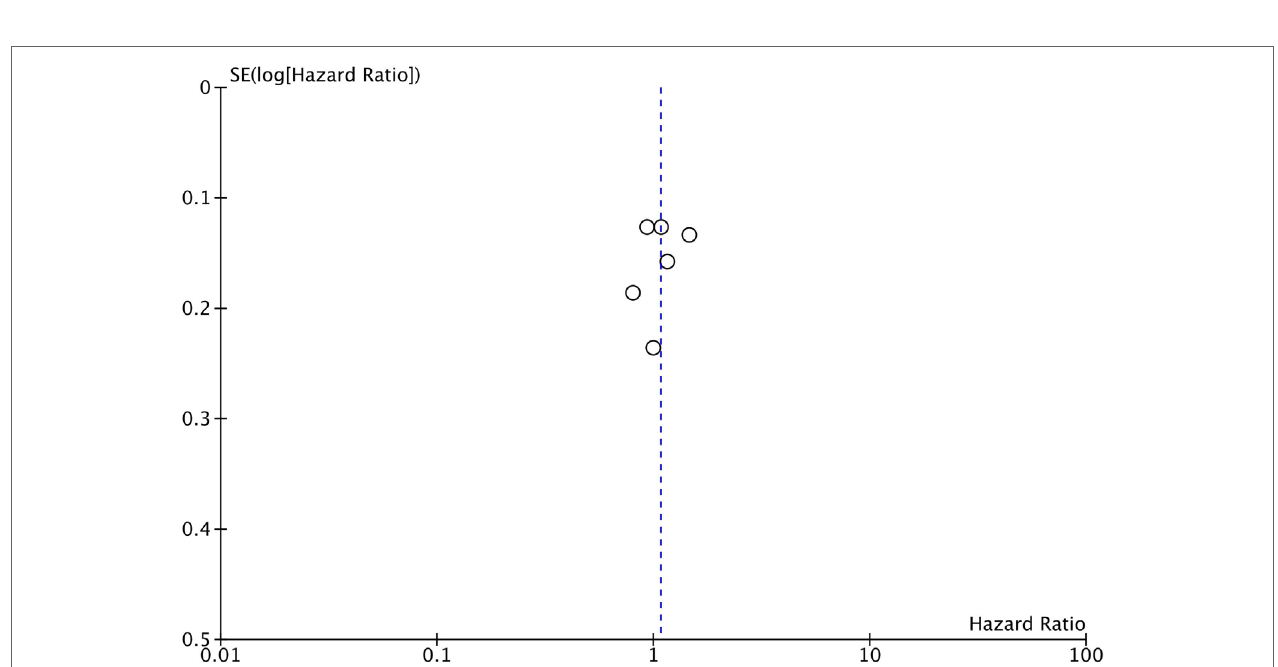
FigURe 6 | Inverted funnel plot for trials addressing overall survival.